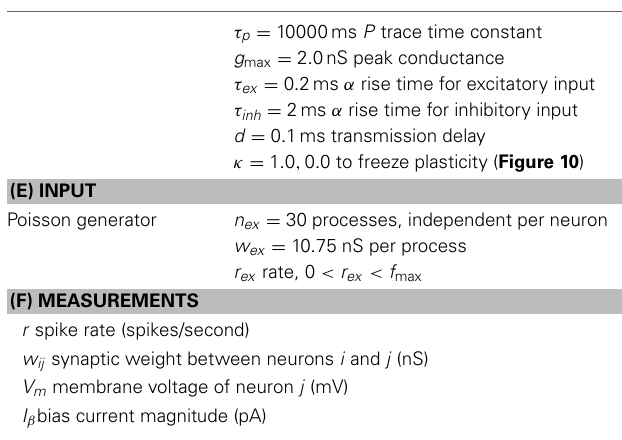
( Figure 4B ) binary output units of abstract BCPNN and IAF neurons of spike-based BCPNN, a close correspondence between their resulting weight and bias trajectories was confirmed ( Figure 4C ). Five separate cases were tested in order to robustly sample statistical relationships among a diverse set of